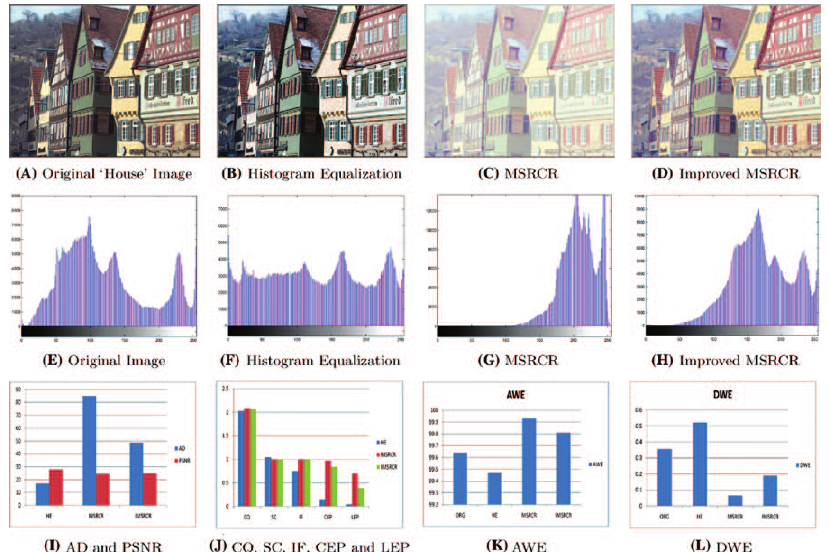
Figure 12. (Top) Image Enhancement Methods. (Middle) Histogram Plots: x -axis, Intensity Levels Ranging from 0 to 255; y -axis, Total Number of Pixels. (Bottom) Conventional Metrics and Proposed AWE and DWE Metrics. The “House” Image has been Downloaded from